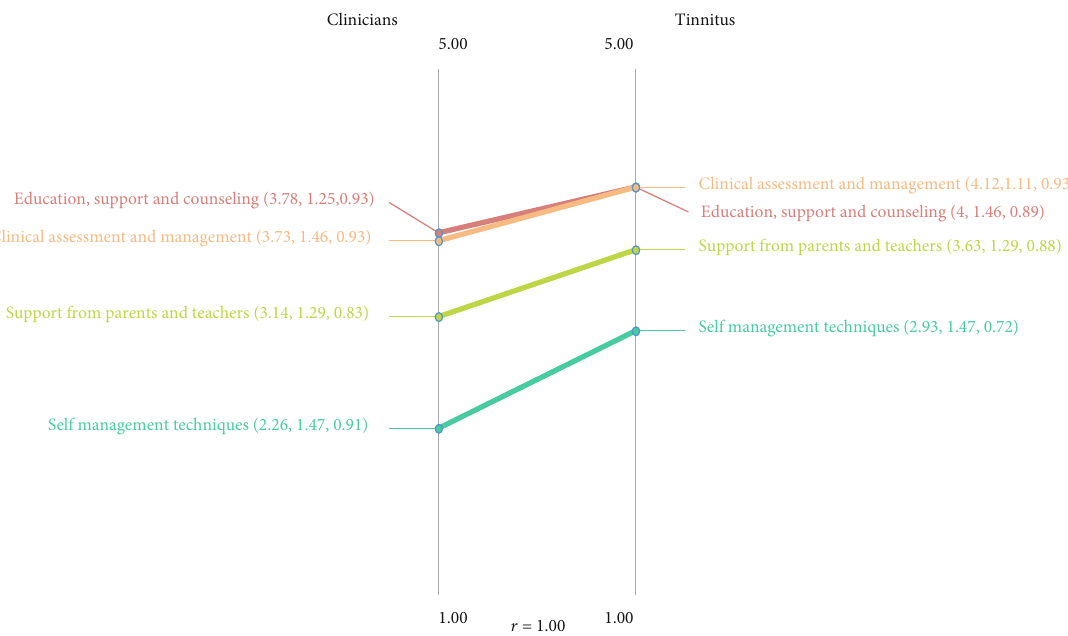
Figure 2: Pattern match graph comparing the tinnitus group and clinician ’ s ratings for the degree of bene fi t associated with each of the clusters for “ What is done to reduce the impact of chronic tinnitus on children ’ s and adolescents ’ lives? ” The median rating scores, standard deviations, and Cronbach ’ s alpha scores are provided in brackets with a score ranging from 0.79 indicating a low to mild degree of bene fi t to 4.75 indicating between signi fi cant to highly bene fi cial.